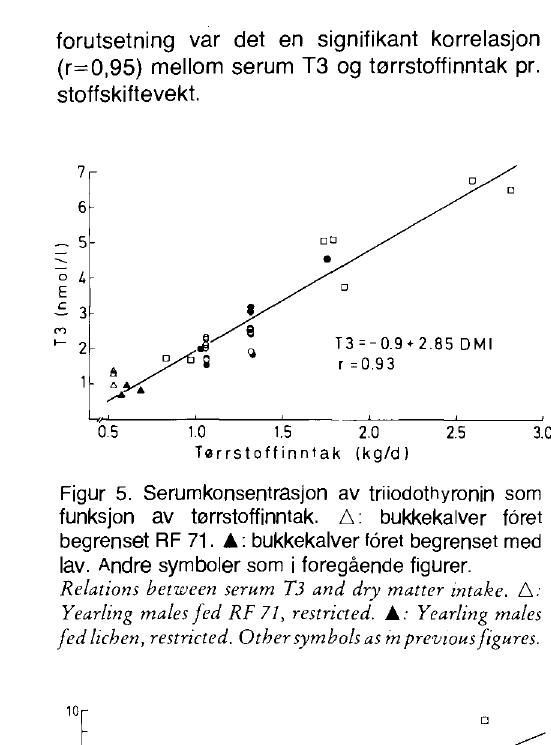
Figur 5. Serumkonsentrasjon av triiodothyronin som funksjon av tørrstoffinntak. A: bukkekalver foret begrenset RF 71. •: bukkekalver foret begrenset med lav. Andre symboler som i foregående figurer. Relations between serum T3 and dry matter intake. A: Yearling males fed RF 71, restricted. A: Yearling males fed lichen, restricted. Other symbols as m previous figures.